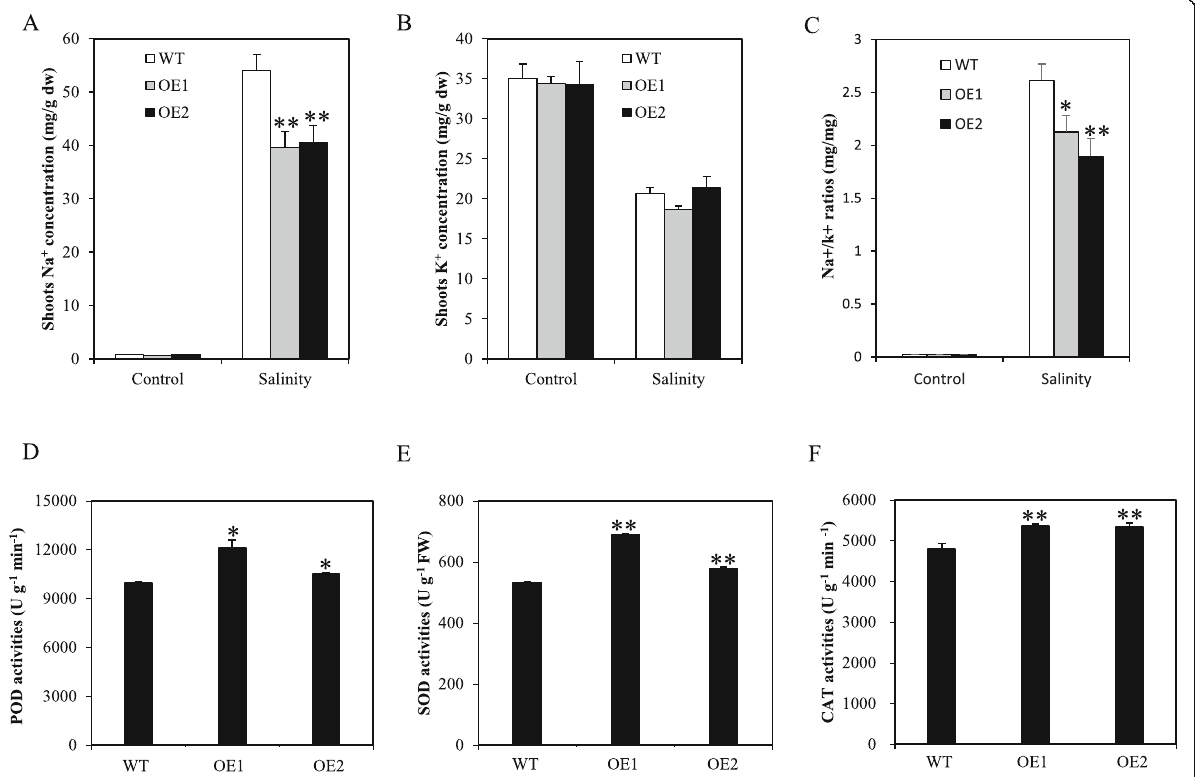
Fig. 6 Physiological trait performances in WT and OsSTAP1 -OE plants in response to salt stress. Determination of Na + ( a ) and K + ( b ) concentrations, the Na + /K + ratios ( c ) and the activities of POD ( d ), SOD ( e ), and CAT ( f ) in rice shoots under salt stress. Each column are means ±SD ( n =3. * and ** indicate significant difference at P <0.05 and P <0.01, respectively, based on Dunnett ’ s multiple comparison tests in ANOVA)